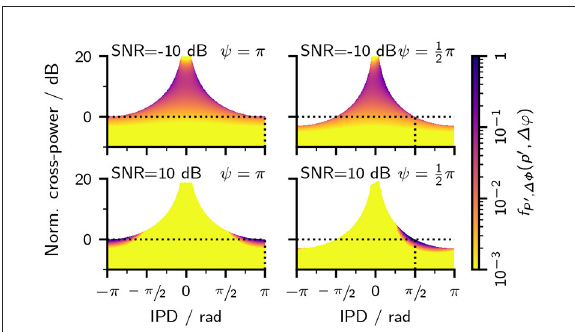
FIGURE4 Joint probability functions of the cross-power P ′ and IPD as defined in Equation (20). For better comparison, the y-axis was normalized with the squared tone amplitude so that the y-axis p ′ / C 2 shows 10log 10 . The top row shows PDFs at an SNR of 10dB, while the bottom row shows PDFs at an SNR of 10dB. (cid:0) (cid:1) − Columns show Each panel shows a PDF at different SNRs and Tone-IPDs ψ . The horizontal dashed black lines indicate the C 2 so that the normalized cross-power is location where p ′ = 0dB. The vertical black lines indicate where the IPD matches the ψ . Note that the color map is tone-phase 1ϕ = logarithmically-scaled and that changes in the scale were limited to values between 1 and 10 − 3